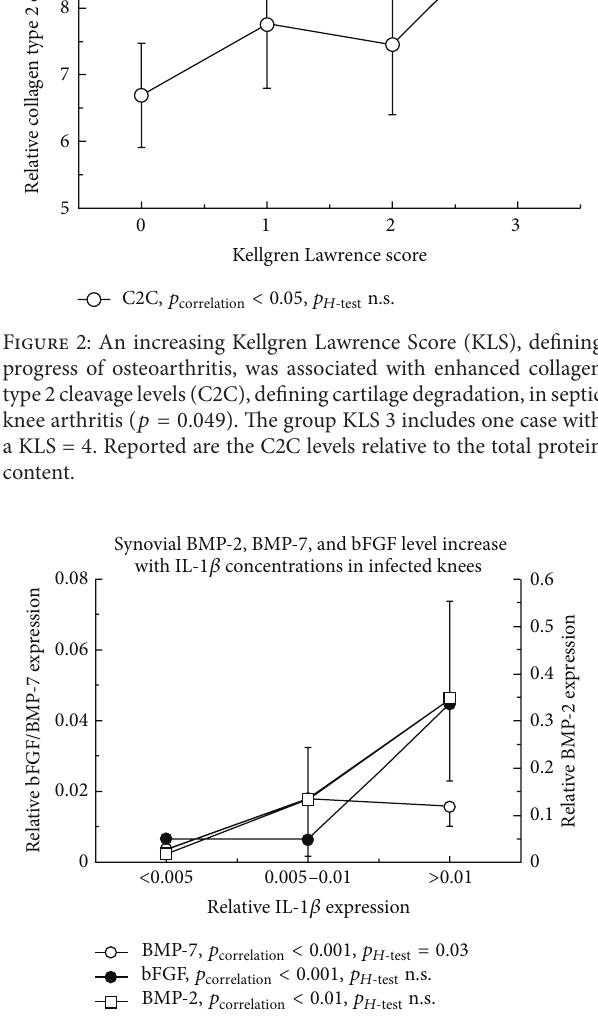
Figure 3: Increased synovial IL-1 𝛽 levels were associated with enhanced bFGF, BMP-2, and BMP-7 concentrations in septic knee arthritis ( 𝑝 < 0.001 ). All protein levels were analyzed relative to the synovial total protein